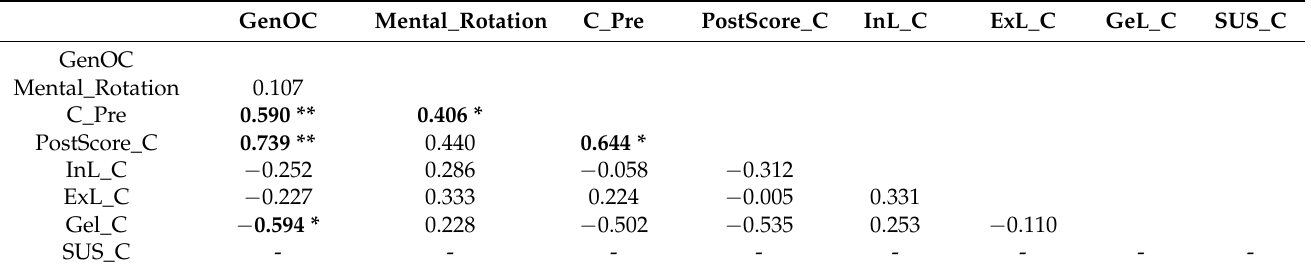
Figure 6. Cognitive load for the topic carbonyl-chemistry (n = 27). Table 5. Correlations for group one (NonAR) for the topic carbonyl-chemistry.